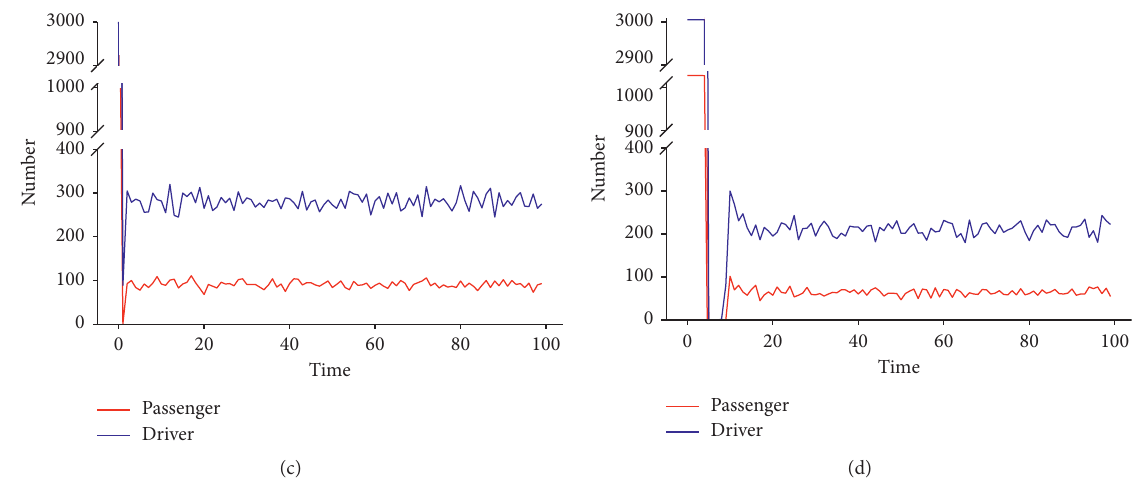
Figure 9: The Fermi learning results. There are totally 3000 drivers and 1000 passengers in the systems. (a, c) λ � 1; (b, d) λ � 5. The probability of taking a taxi and waiting around hotspots for (a) and (b) at the initial state is half, and for (c) and (d), it is